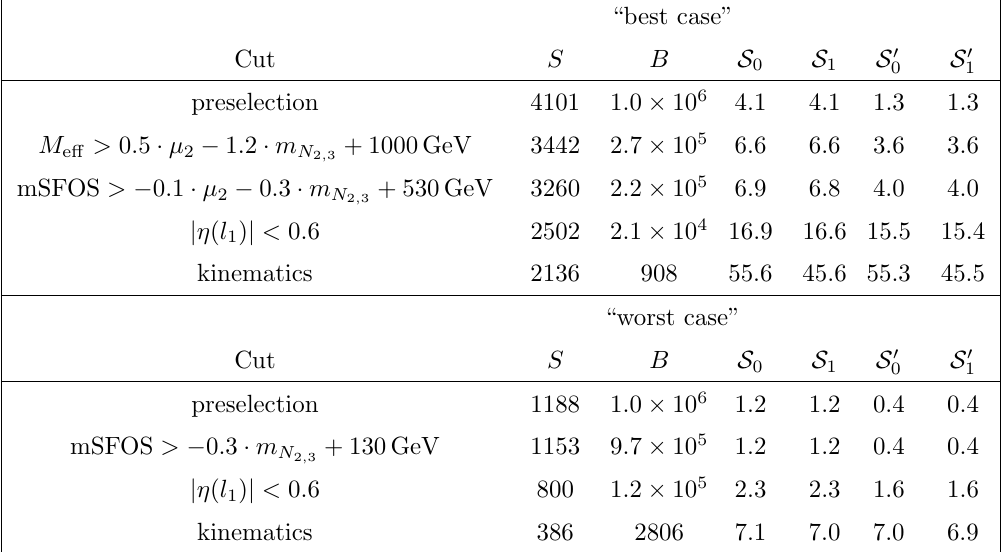
= 500 GeV and m = 1 TeV. 2 ; 3 (cid:6)